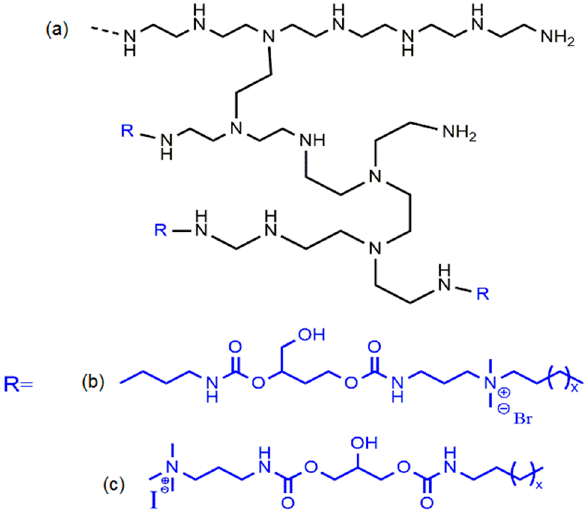
Figure 7. Chemical structures for: ( a ) poly-(ethylene imine); ( b ) alkyl chains directly linked to cationic groups and ( c ) alkyl chains and cationic groups linked by a spacer [150]. Materials 2016 , 9 , 599